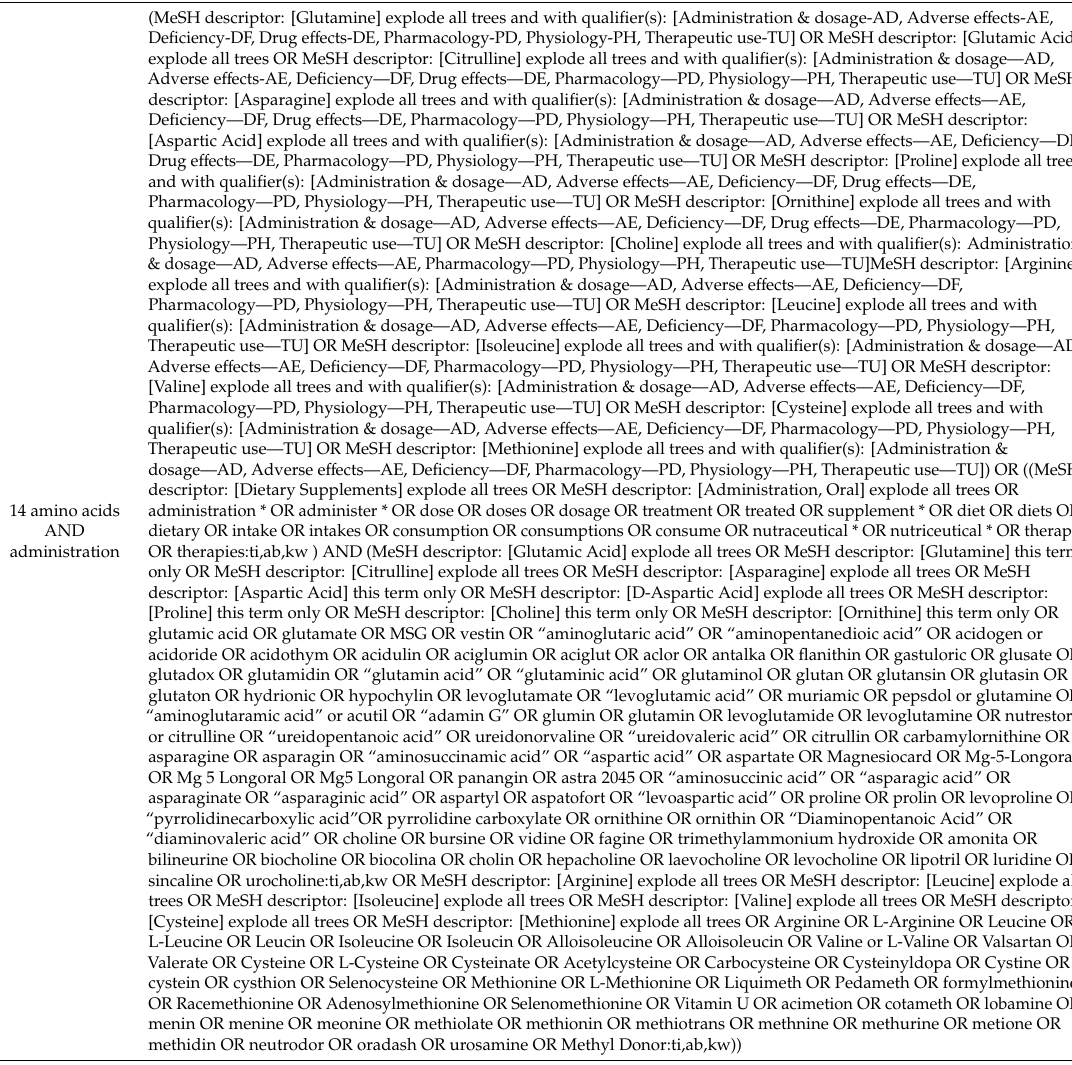
Table A3. Search terms in